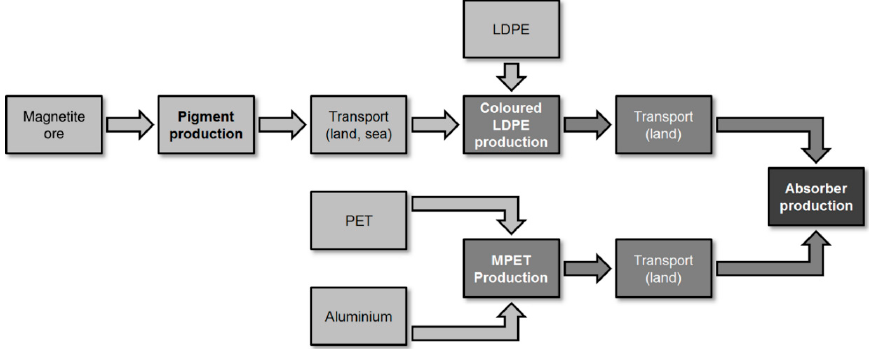
Figure 2. Scheme of the P1 absorber production considered in the life cycle assessment (LCA).